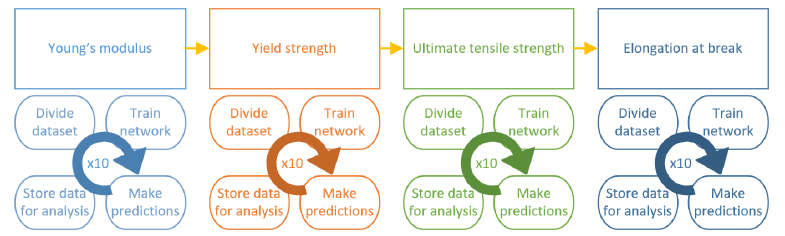
Figure 4. Training and prediction phases